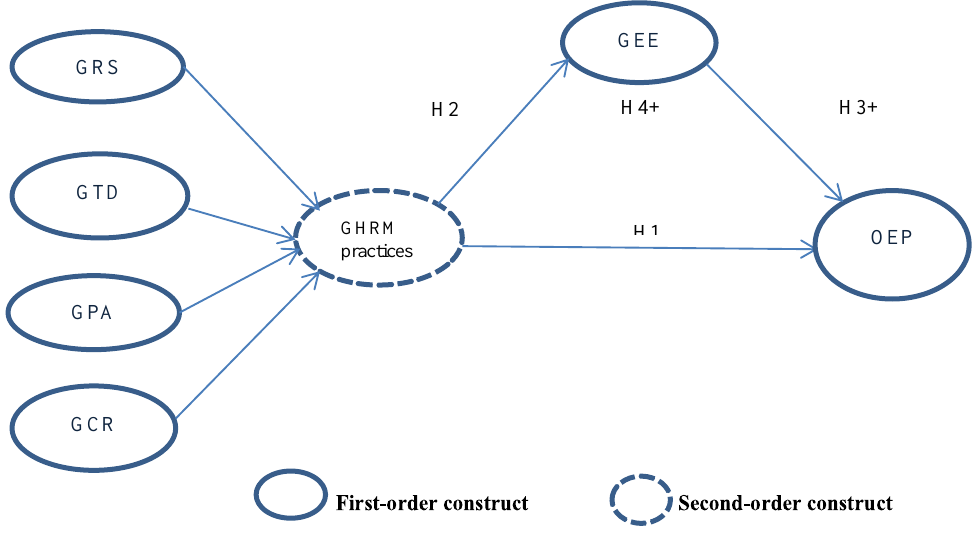
Figure 1: Conceptual Framework of the